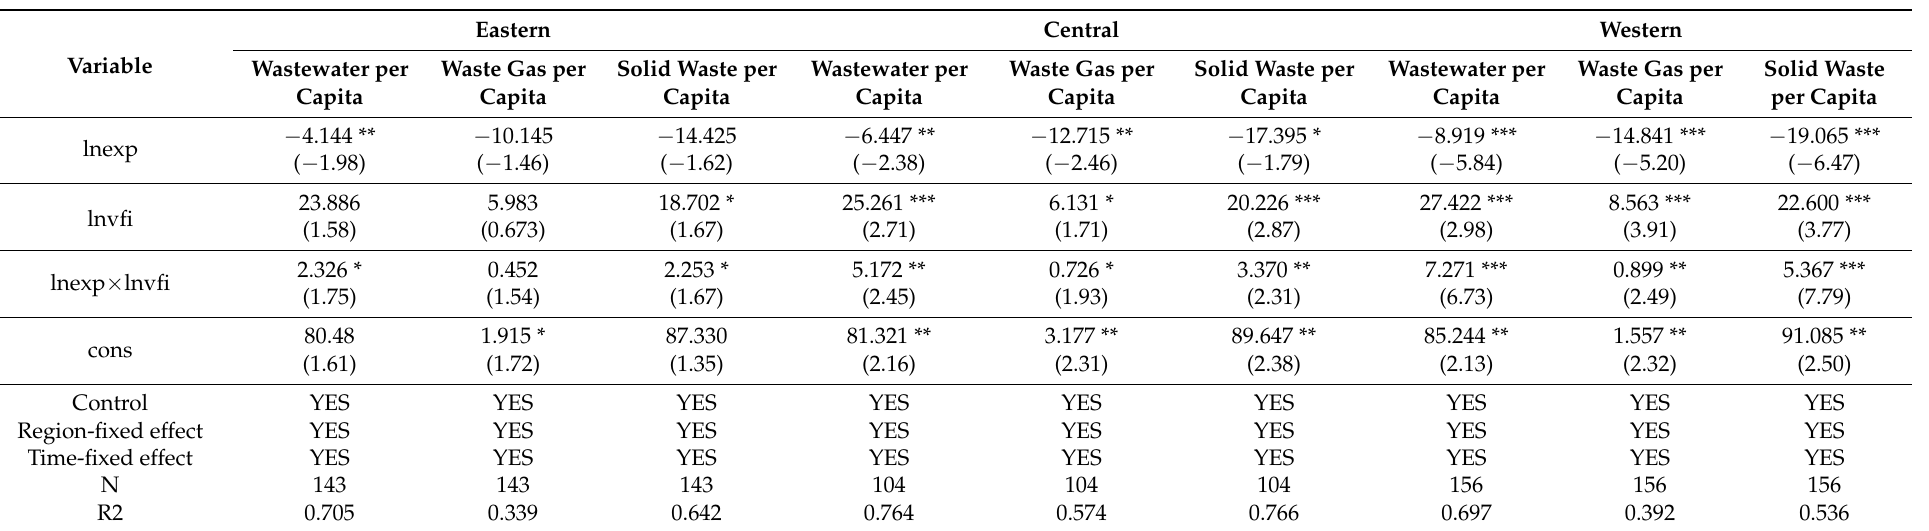
Table 9. Heterogeneity